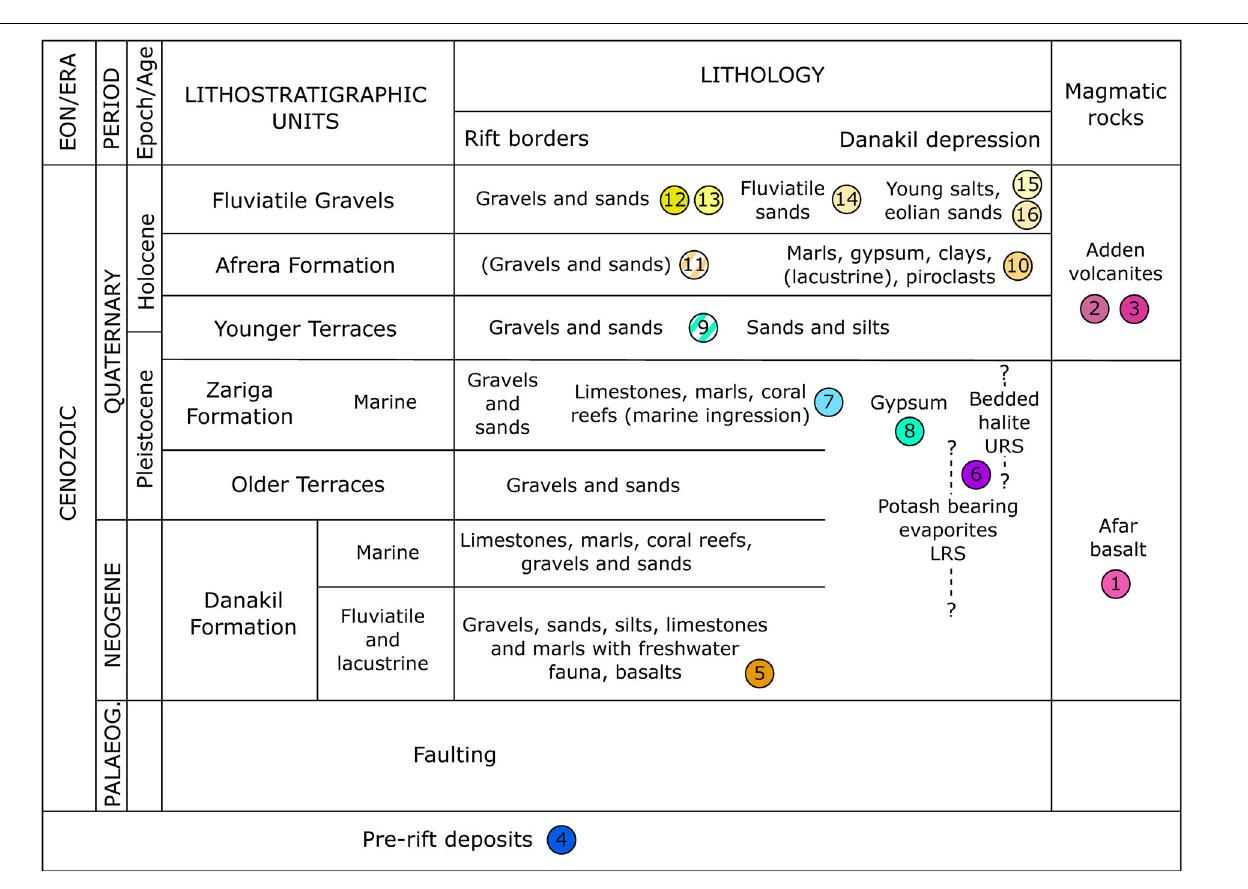
FIGURE 2 | Lithostratigraphy of the Danakil depression. The chart was modified after (Brinckmann and Kürsten, 1971; Jaramillo-Vogel et al., 2018). Numbers correspond to map units in Figures 1B,C